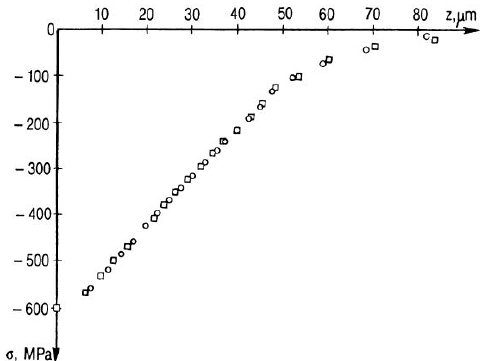
Fig. 2 Measured compression stresses as function of the depth of a chemically tempered glass sample. (Aben and Guillemet, 1993 apud Gy 2007)